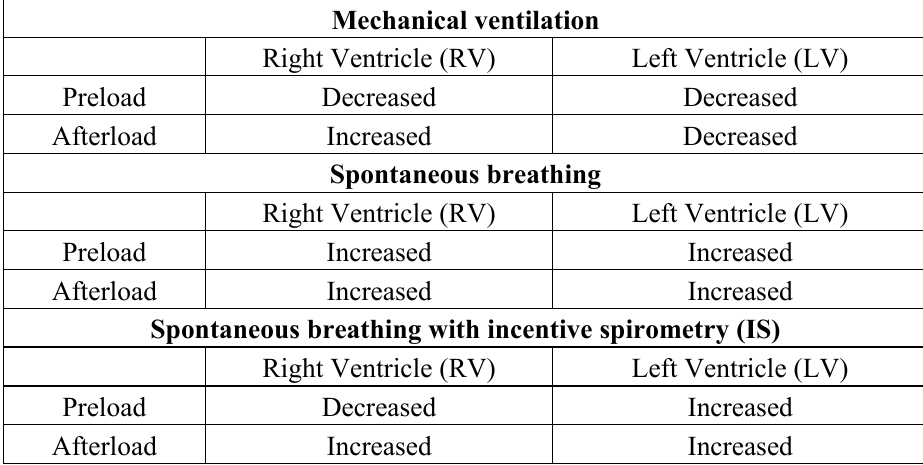
Table 1. The impact of mechanical ventilation, spontaneous breathing and spontaneous breathing through the incentive spirometry on right and left ventricular preload and afterload. Bothe positive pressure inspiration and spontaneous inspiration increase pulmonary vascular resistance RV